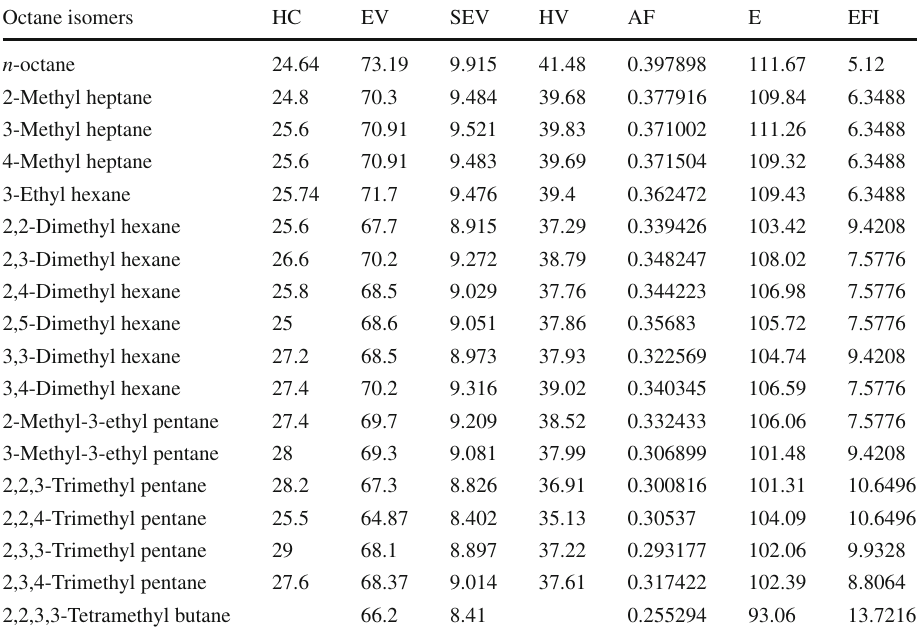
Table 1 The value of some properties and edge F-index for octane